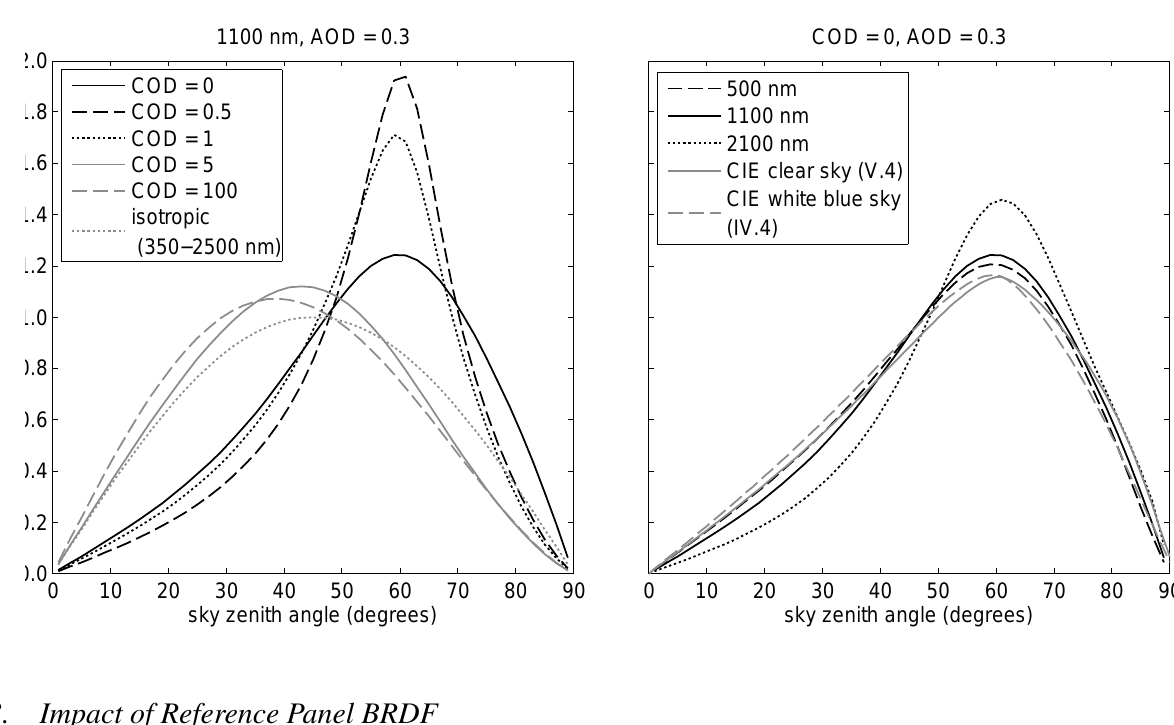
Figure 3. Angular distribution of diffuse incident light expressed as a weight function, for different values of cloud optical depth (left figure) and wavelengths (right figure) simulated with SBDart or derived from the CIE formulations [20] for a 60° solar zenith